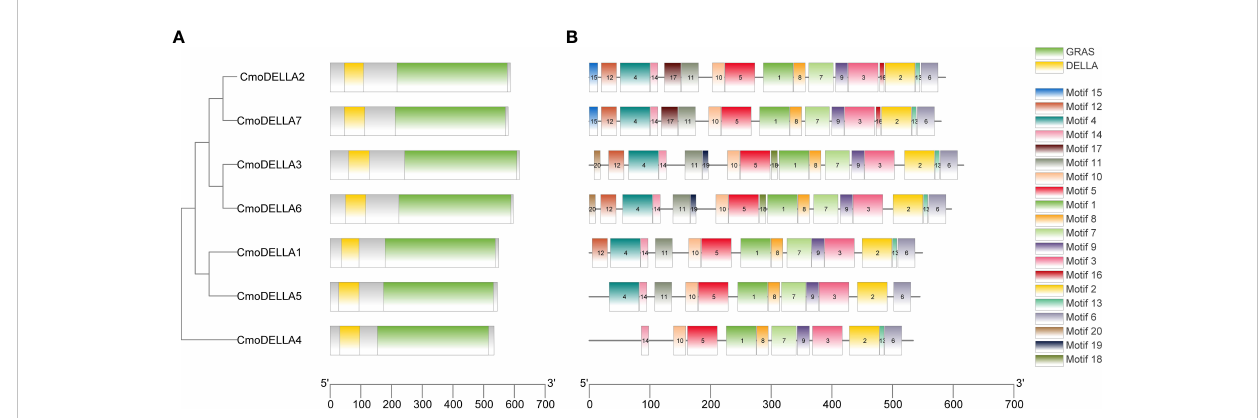
FIGURE 4 The conserved domains and conserved motifs of CmoDELLA proteins. The lengths of the conserved domains and conserved motifs are shown proportionally. (A) The conserved domains of CmoDELLA proteins. DELLA domain and GRAS domain are represented by yellow and green box, respectively. (B) The conserved motifs of CmoDELLA proteins. The different conserved motifs are indicated by different colored